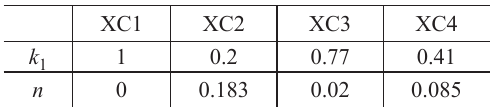
Table 1. Values of k 1 factor and n factor